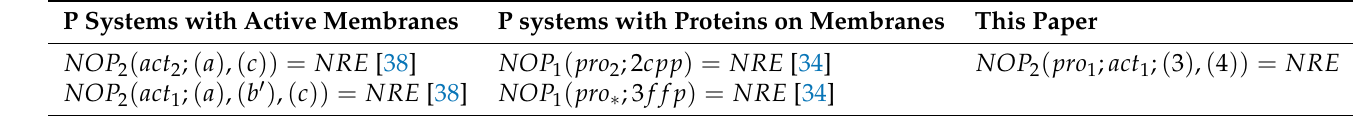
Table 1. Results of the P systems with active membranes, P systems with proteins on membranes and this paper, where NOP m ( pro r ; act c ; list − of − rules ) represents the family of all sets of numbers pro- duced by P systems with m membranes, r proteins in each membrane, and which use c polarizations and types of rules list − of − rules ; ∗ represents the case where parameter m or r are boundless; the types of rules 2 cpp or 3 f f p combined with the polarizations of membranes become the types of rules ( 3 ) and ( 4 ) ; the types of rules ( b ) and ( c ) combined with proteins on membranes become the types of rules ( 3 ) and ( 4 ) ; the types of rules ( 3 ) and ( 4 ) are defined in this paper; and NRE is the family of all recursively enumerable sets of natural